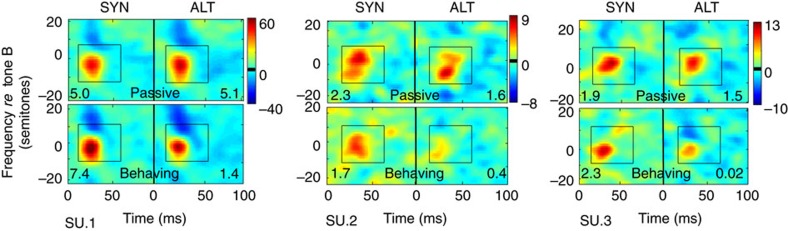
Examples of STRF changes in single units.For each of the three cells, the STRFs in the top panels were measured during the Target epoch after the animal listened passively to the SYN or ALT sequences. The bottom panels were STRFs measured with the same stimuli but during task performance. In these 3 neurons, small differences were seen between the passive STRFs. Significant changes occurred during behaviour with reduction typically following ALT sequences and enhancement following SYN sequences. The average of the STRF within the central highlighted region is indicated in the corner of each STRF.